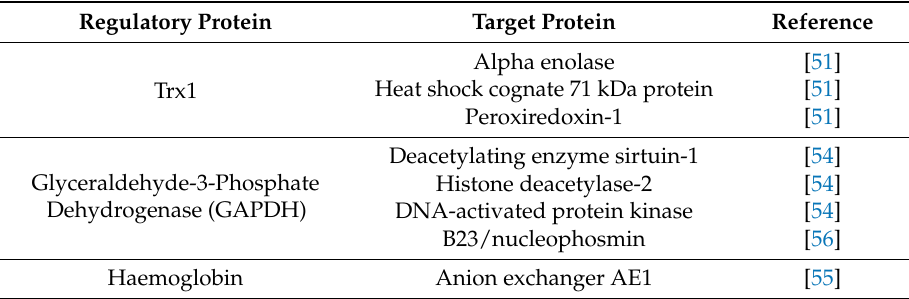
Table 1. The proteins for transnitrosylation through protein-protein